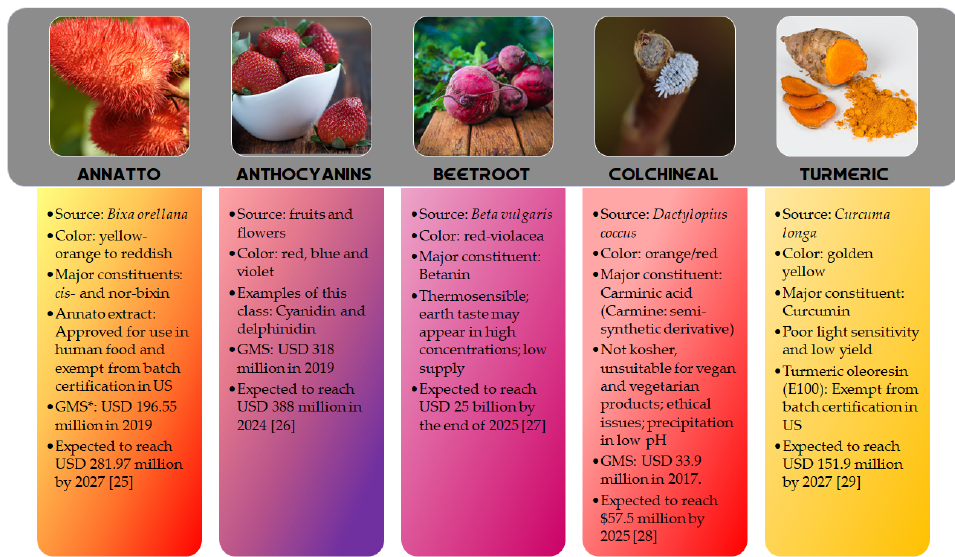
Figure 1. Source, color, constitution and global market size (GMS) data for some vegetal-originated colored compounds [25 –